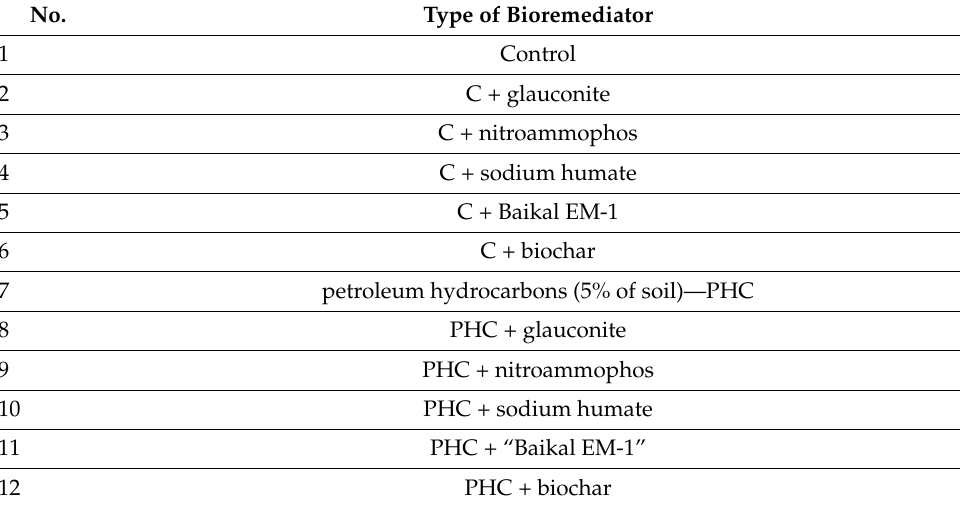
Table 3. Scheme of an experiment on the bioremediation of petroleum hydrocarbon-contaminated